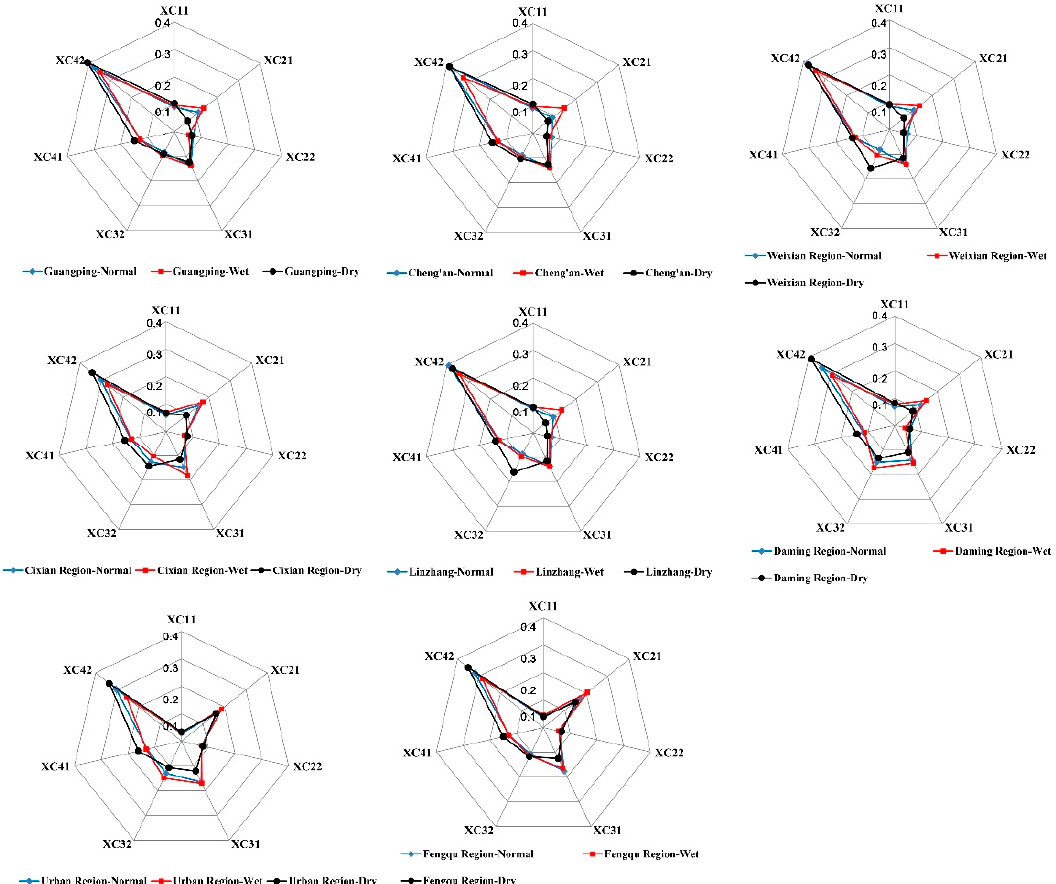
Figure 11. Contribution ratio of different factors to the comprehensive SWA in Guangping, Cheng’an, Weixian, Cixian, Linzhang, Daming, Fengqu, and urban regions in different hydrological-level years. As shown in Table 1, the factor of C11 represents the valid physical capacity of the soil reservoir, C21 represents the average value of the annual empty storage capacity of the soil reservoir, C22 is the factor for the average annual variation of the empty storage capacity of the soil reservoir, C31 represents the factor for the temporal matching degree between the soil water supply and crop water demand, C32 represents the factor for the spatial matching degree between the soil water supply and crop water demand, C41 is the factor for the soil water conversion efficiency, and C42 is the factor for the crop use efficiency of the soil water.